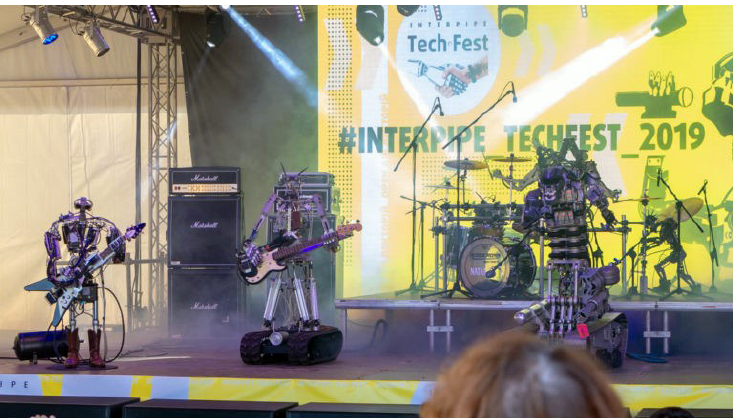
Figure 1. Mechanical music group Compressorhead (2013, Berlin, Germany) in Dnipro, Ukraine in 2020 (source: created by